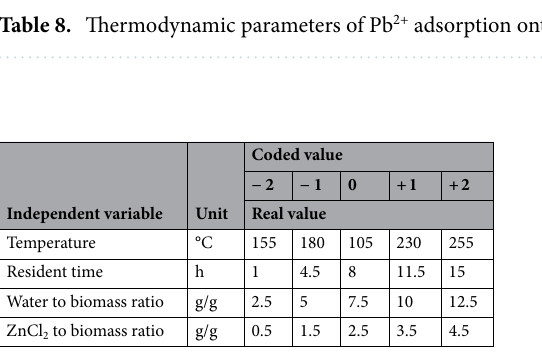
Table 9. Variable range in the central composite